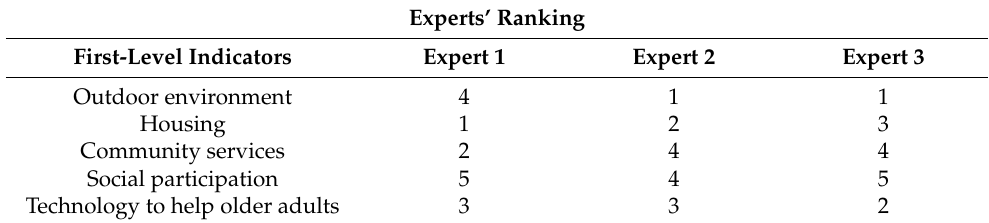
Table 3. The ranking results for the first-level indicators by experts.